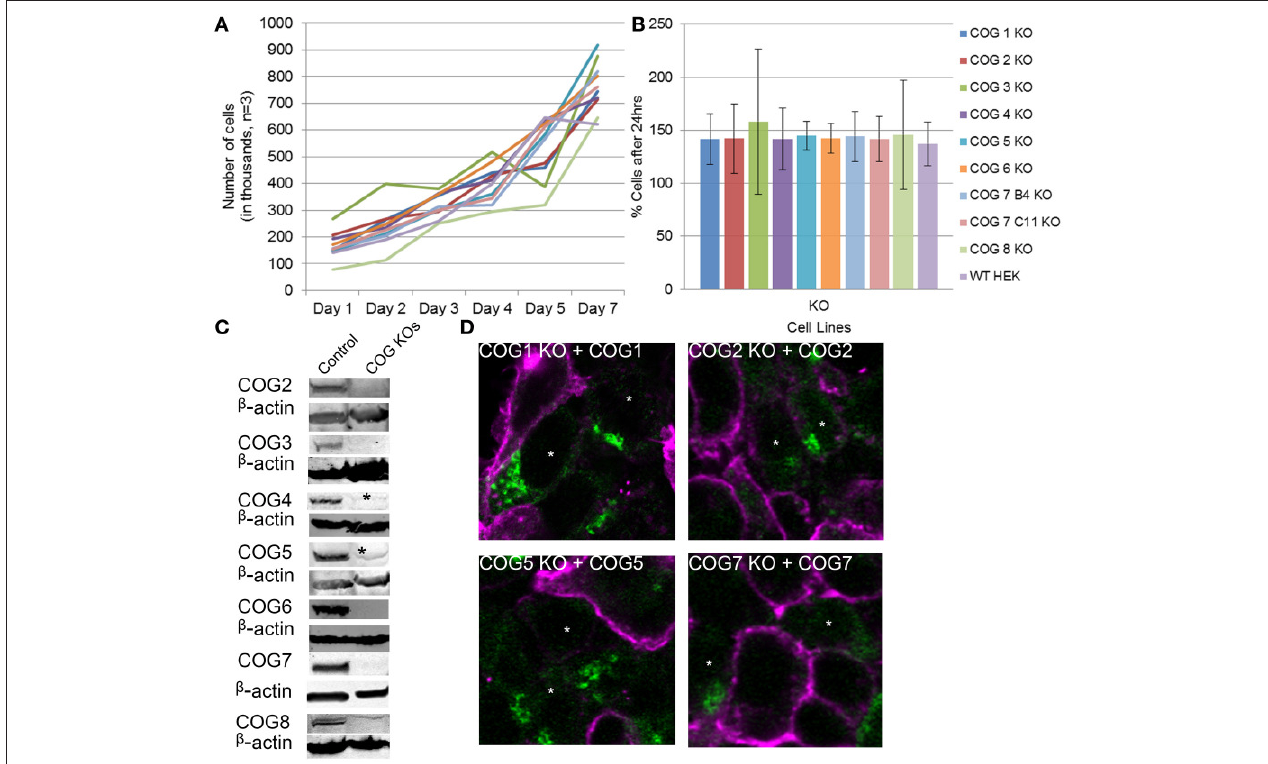
FIGURE 2 | Growth and rescue of COG KO cells. (A) Growth of WT and KO cells. Cells were plated in 24 well plates in triplicate at 100,000 cells per well (Day 0). Cells were counted at the indicated time points over a week and cell counts were plotted. (B) The average growth in a 24 h period was calculated by (# of cells on day n/ # of cells on day n-1) * 100 to get percent growth per day. Growth percentages over the week for each cell line were averaged. (C) Western blot analysis for each COG subunit KO cell line. β -actin is used as a loading control. Asterisks indicate non-specific bands. (D) Rescue of COG dependent glycosylation defect. Missing COG subunits (green) were transfected into KO cells. Seventy two hours later cells were fixed and stained with GNL-Alexa 647 (pink). Note that GNL binding was significantly reduced in cells expressing COG subunits.